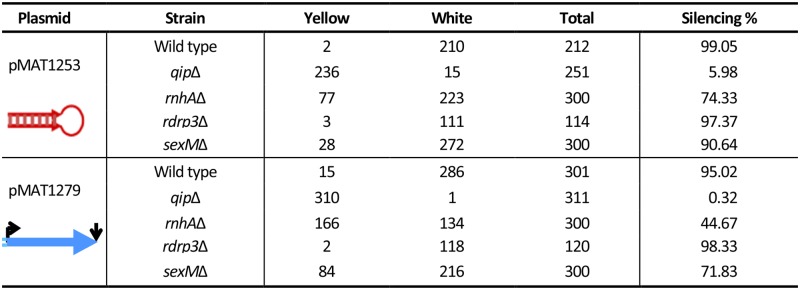
Exogenously activated silencing frequency of the qip, rdrp3, rnhA, and sexM null mutants.The color of the colonies was observed after subculture of the original transformants on YNB pH = 4.5 plates and incubation for 4 to 5 days in the light. Colonies with white patches were scored as white transformants.